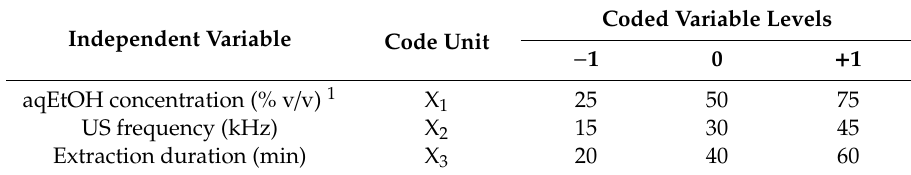
Table 1. Identity, code unit, coded level and experimental values of the 3 independent